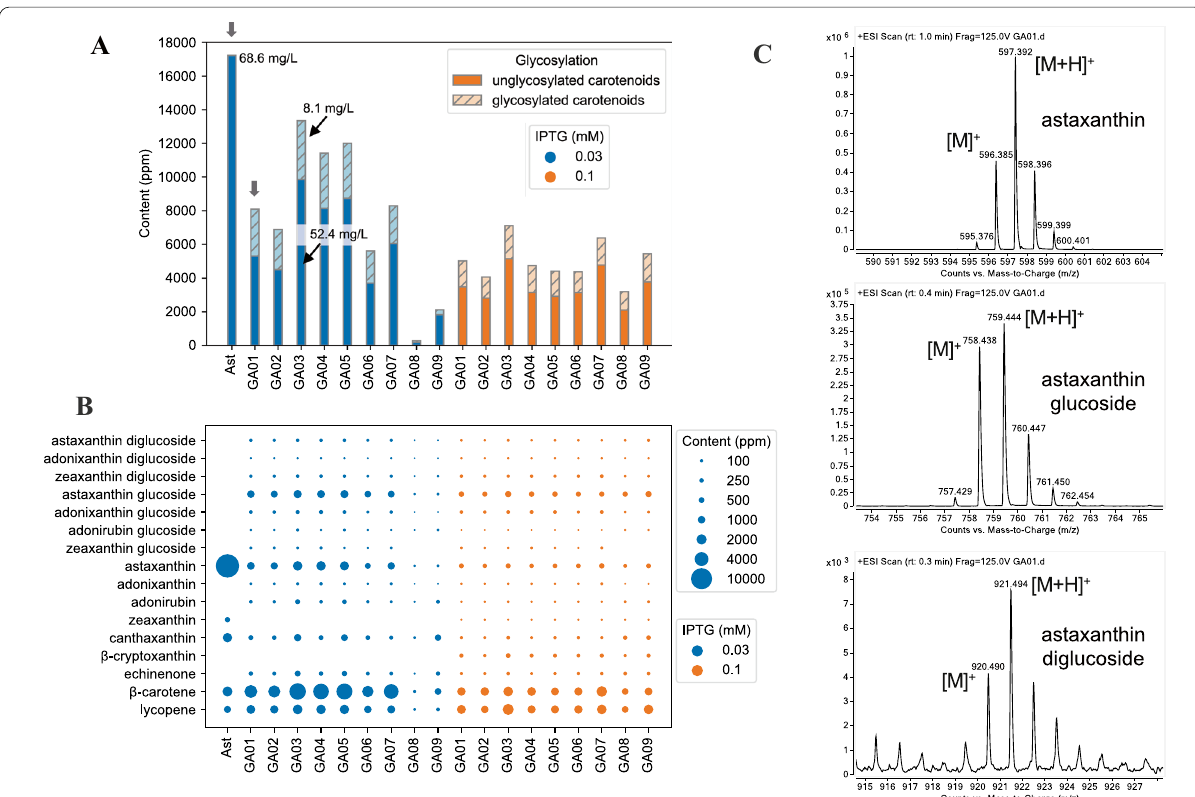
Fig. 6 Production of astaxanthin glucosides and other carotenoids. A The content sums of glycosylated and unglycosylated carotenoids in different strains. The arrows refer to the two control strains (‘Ast’ and ‘GA01’). B Carotenoid contents produced in different strains. Blue: 0.03 mM IPTG; orange: 0.1 mM IPTG. ‘Ast’ strain is the parental astaxanthin strain without expressing crtX . ‘GA01’ is the control strain with the highest RBS strength of crtZ . C Mass spectra of astaxanthin and its